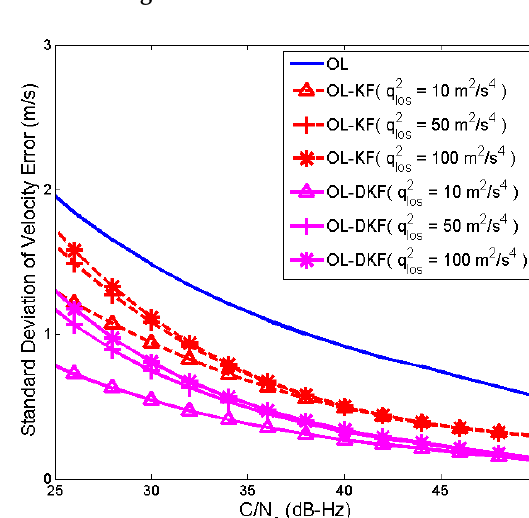
Figure 8. Satellite constellations.